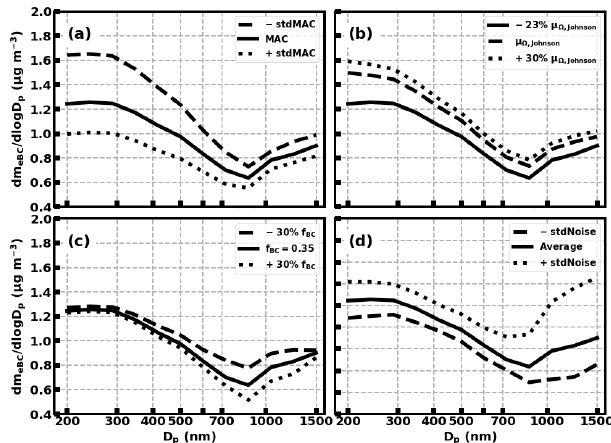
Figure 4. Uncertainty in eBCMSD AAC − AE33 arising from (a) MAC lookup table, (b) transfer function inversion, (c) f BC and (d) instrumental noise. The solid lines in each panel were the same and were the mean eBCMSD AAC − AE33 during the mea- surement period. The dotted lines and dashed lines in each panel were mean eBCMSD AAC − AE33 ± standard deviation (SD) calcu- lated from (a) MAC + SD of MAC and MAC − SD of MAC, (b) µ (cid:127), Johnson and 1 . 3 × µ (cid:127), Johnson , (c) f BC of 35% × 0 . 7 and 1.3, and (d) eBCMSD AAC − AE33 + SD of instrumental noise and − SD of instrumental